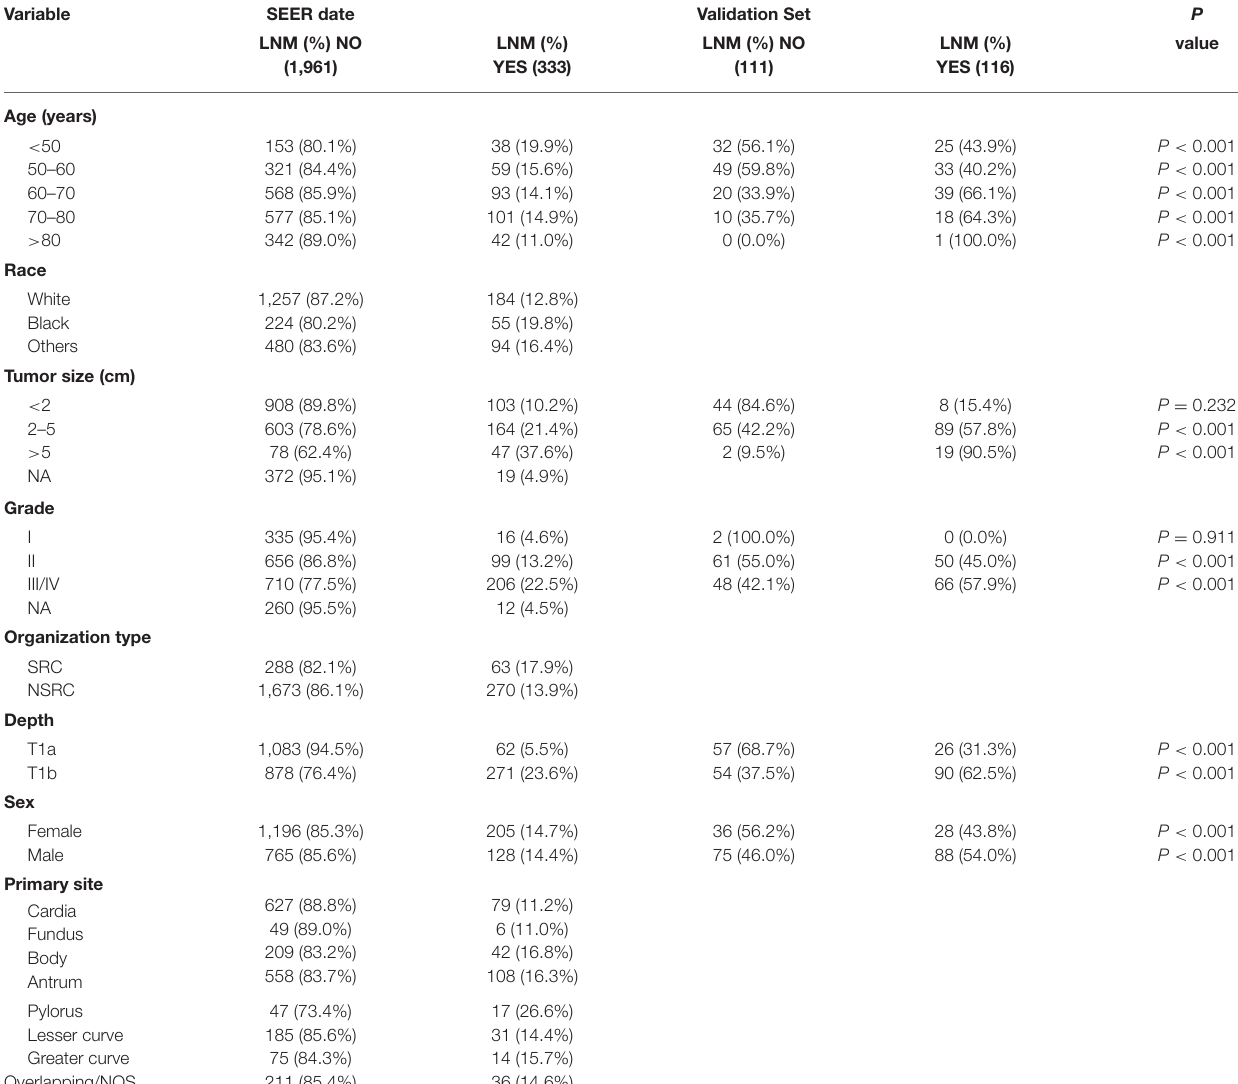
TABLE 1 | Clinical and pathological characteristics of SEER date and validation